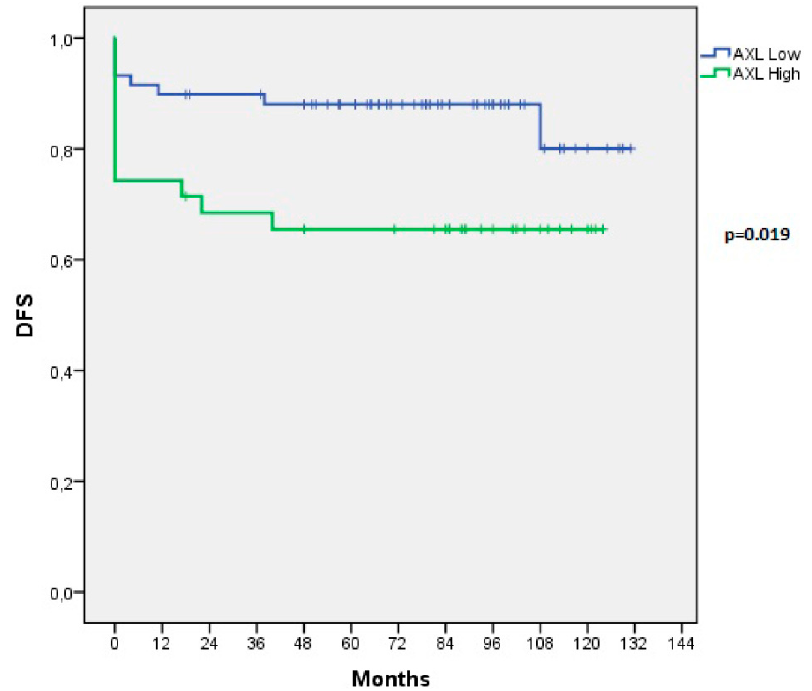
Figure 3. Kaplan-Meier estimation of Disease Free Survival (DFS) in thyroid cancer patients depending on AXL expression. Disease Free Survival curves of patients with papillary thyroid cancer stratified in two groups as negative / low or high AXL expression. Persisting patients were included in DFS analysis and the value 0 of the recurrence time was assigned to them in the analysis.